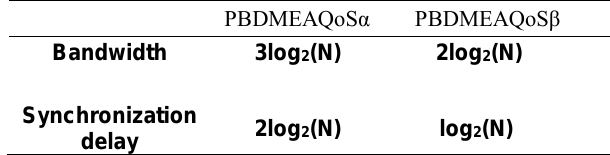
Table 1. C omparison between the PBDMEAQoSα